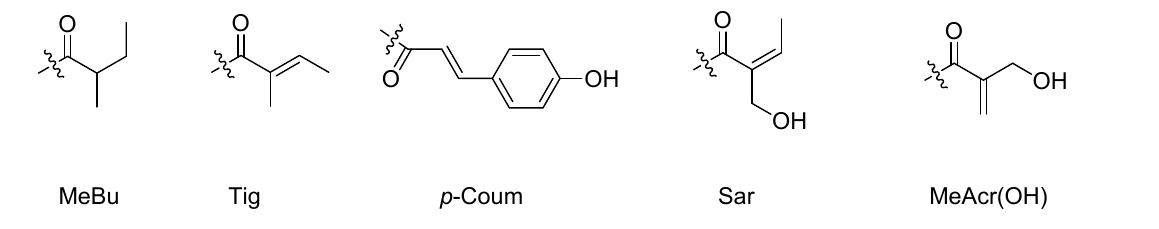
Figure 2. Groups in shorthand.